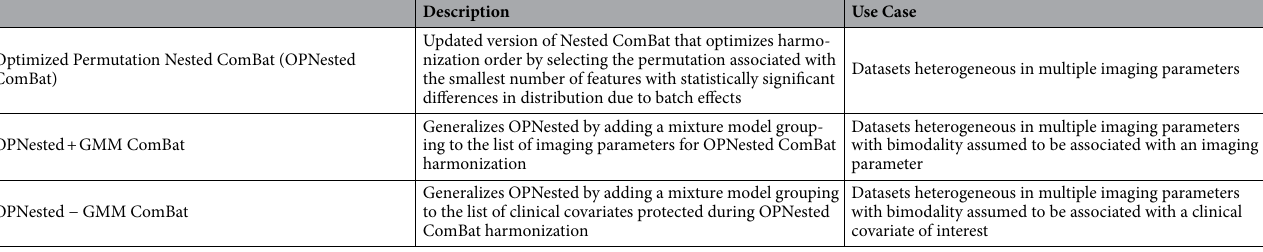
Table 1. Summary of methods introduced in this